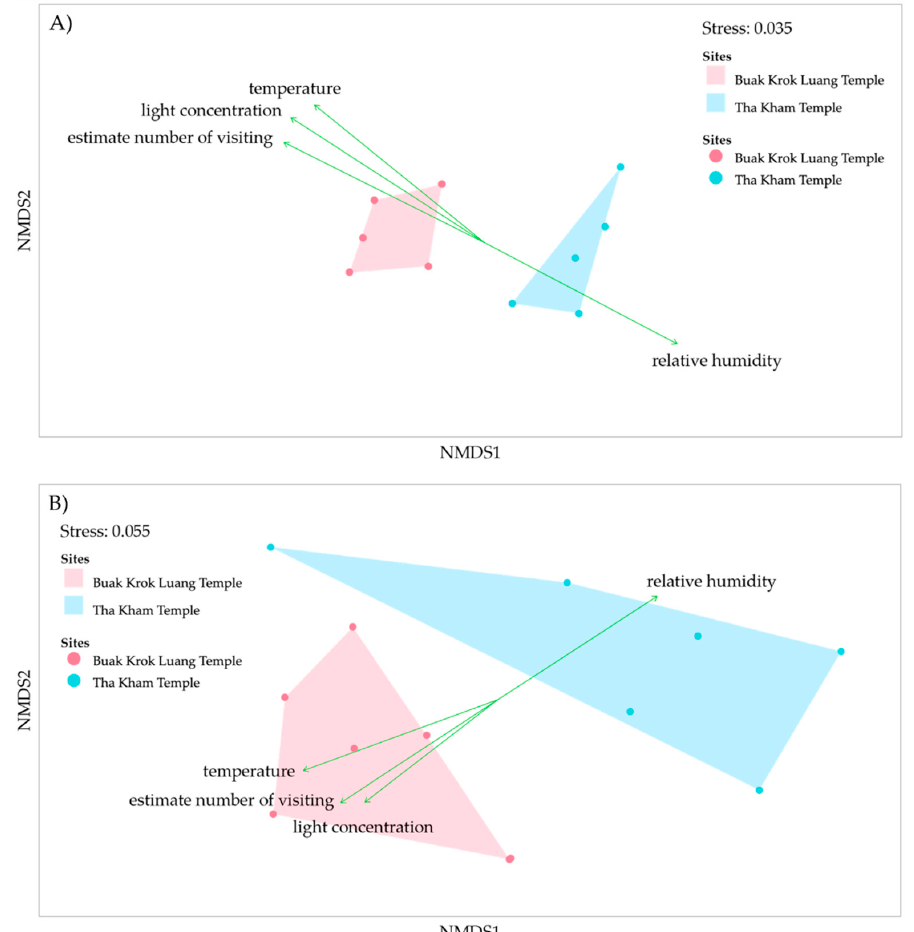
Figure 6. Non-metric Multi-dimensional Scaling (NMDS) with environment parameters of microorganism, bacteria ( A ) and fungi ( B ) on mural paintings from the two temples. The red dots represent the samples from Buak Krok Luang temple while the blue dots represent the samples from Tha Kham temple. The green arrows indicate the factors which impact on the microorganism community in each temple.